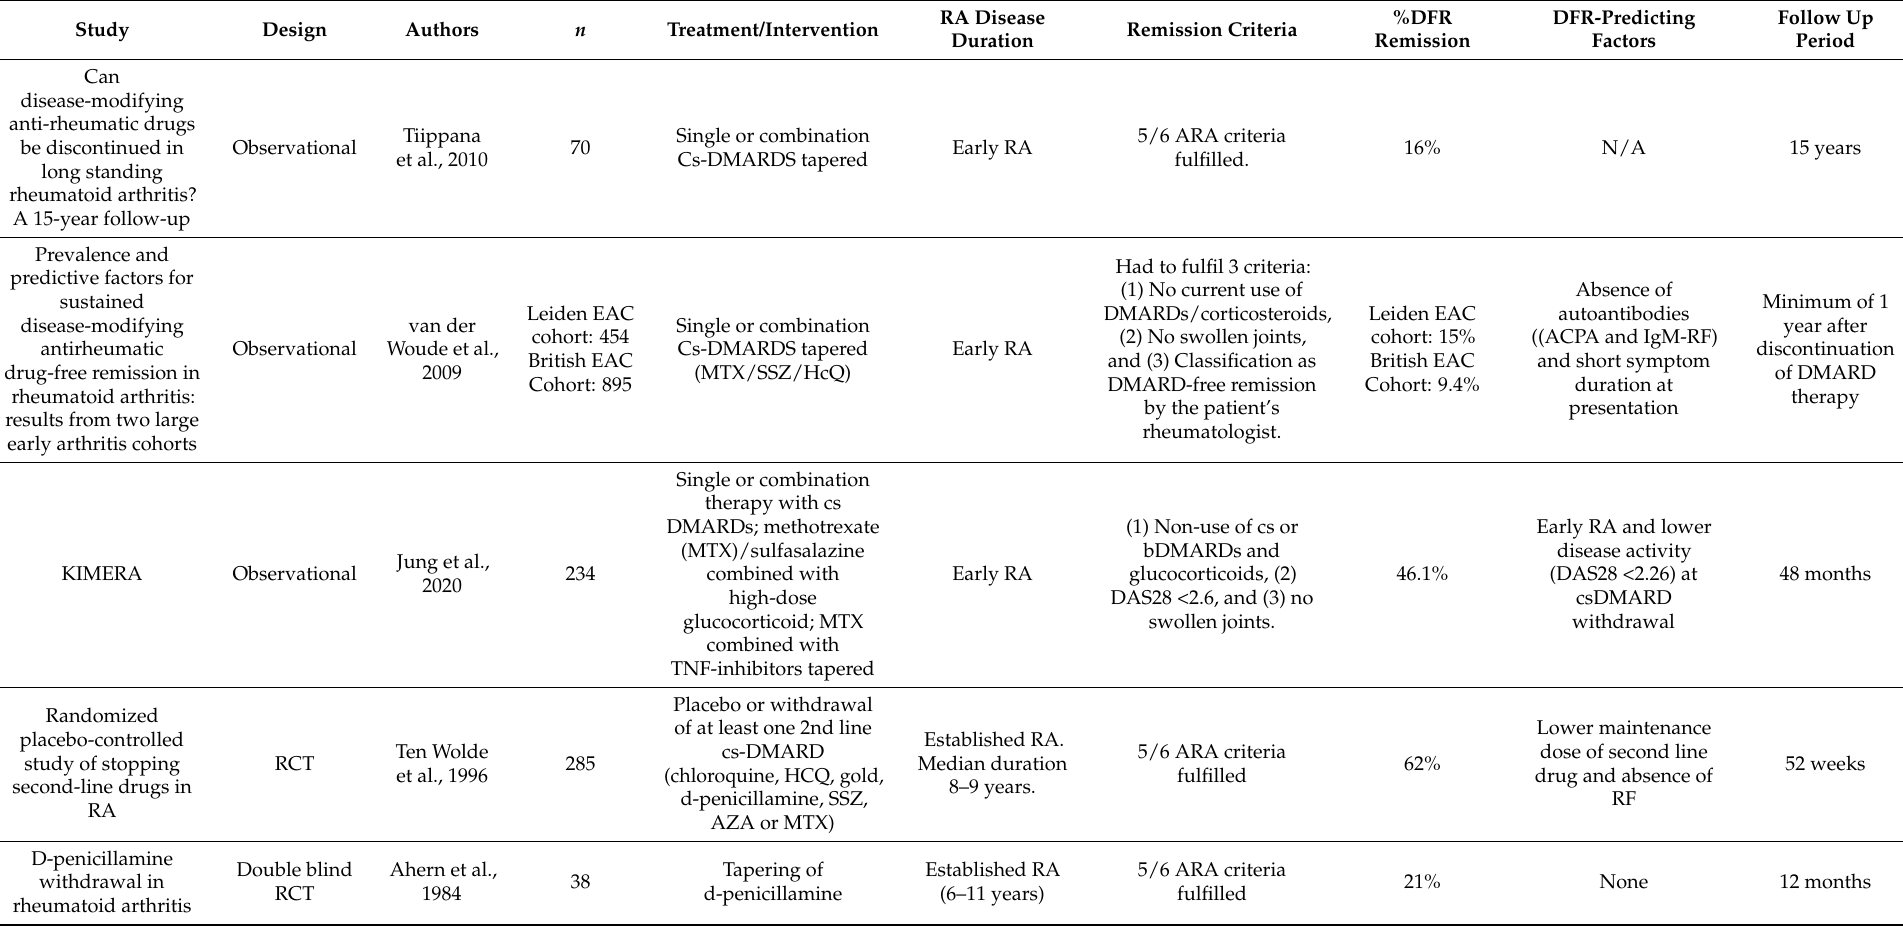
Table 1. cs-DMARD DFR remission